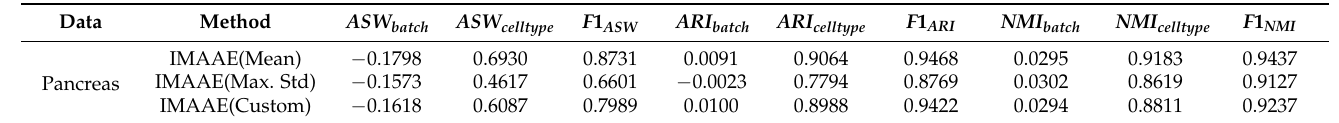
Table 2. Quantitative assessment of the correction results for three anchor batch models using ASW , ARI , NMI , and corresponding F 1